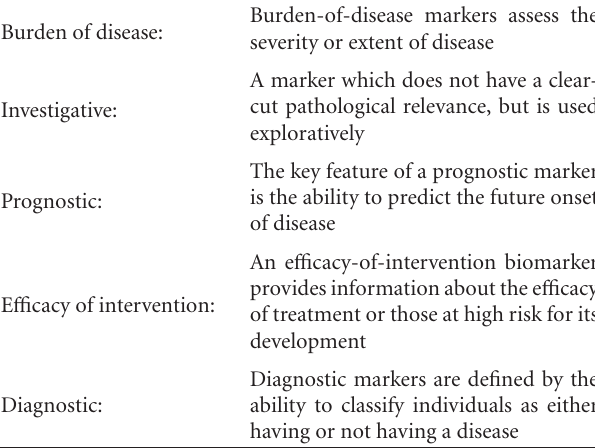
Table 2: BIPED classification adopted from [36].